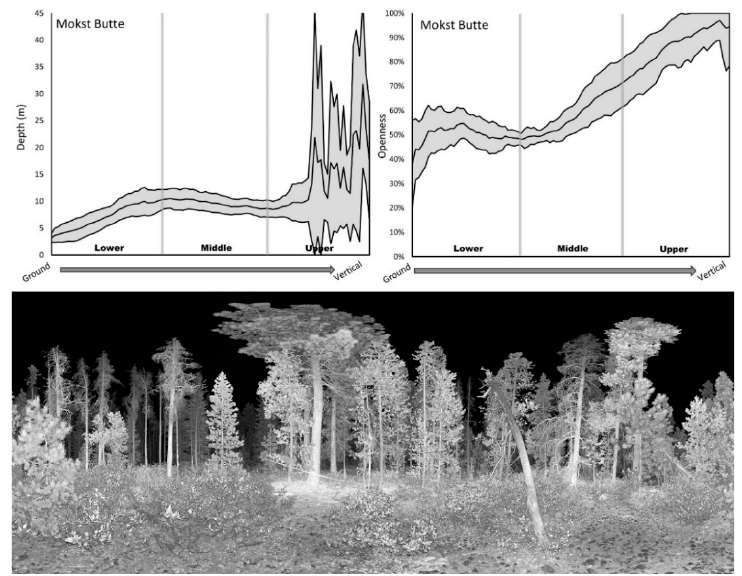
Figure 6. Structural signatures (shaded area is one standard deviation above and below mean) and representative image of Little Sink RNA ( above ) and Mokst Butte RNA ( below ).